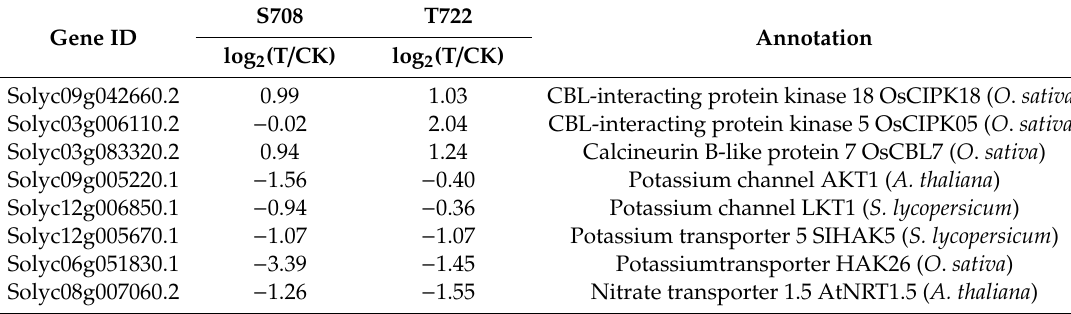
Table 6. List of genes related to K + uptake and translocation in the S708 and the T722 cultivar under sub-optimal temperature conditions (T, 15 / 10 ◦ C). S708 and T722 tomato cultivars grown under normal (CK, 25 / 18 ◦ C) and sub-optimal temperature conditions. Values are the log 2 ratio (T / CK) for genes more than 1 or less than -1 with FDR < 0.05 as the threshold to judge the significance of gene expression di ff erence between the two